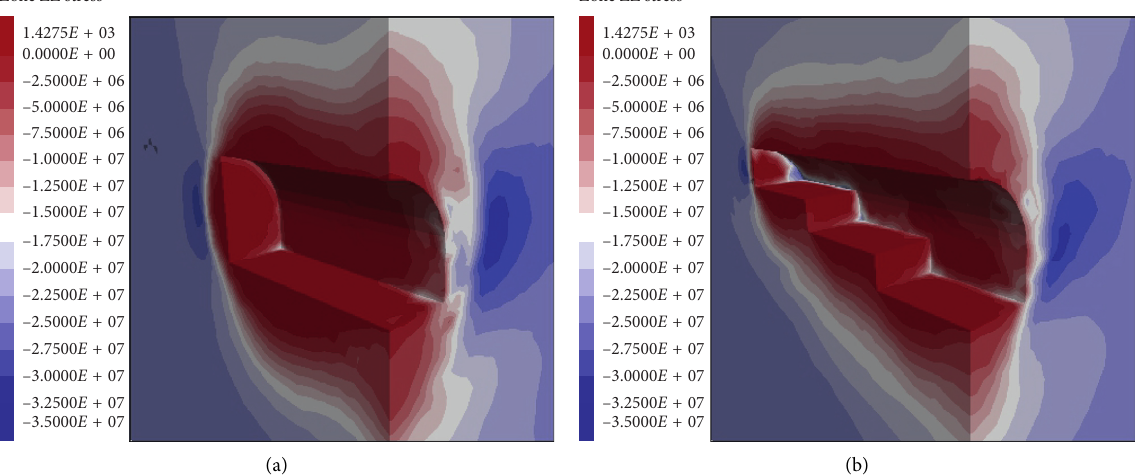
Figure 10: Vertical stress of stepped driving. (a) Nonstepped driving. (b) Stepped